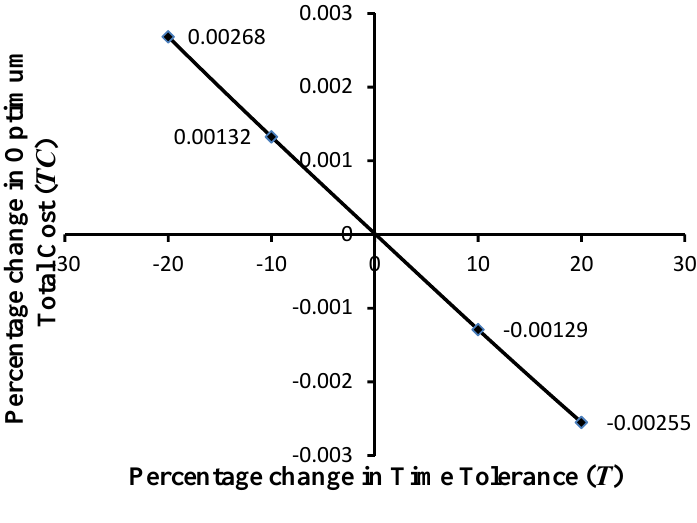
Fig. 3. Total Cost ( TC ) versus Time tolerance ( T )